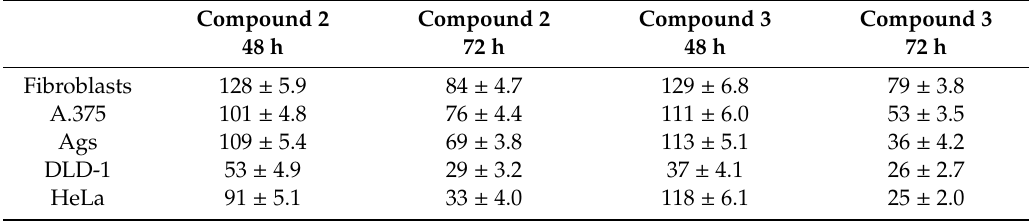
Table 1. IC 50 values ( µ M) of compounds 2 and 3 for fibroblasts and selected cancer cell lines after 48 and 72 h of